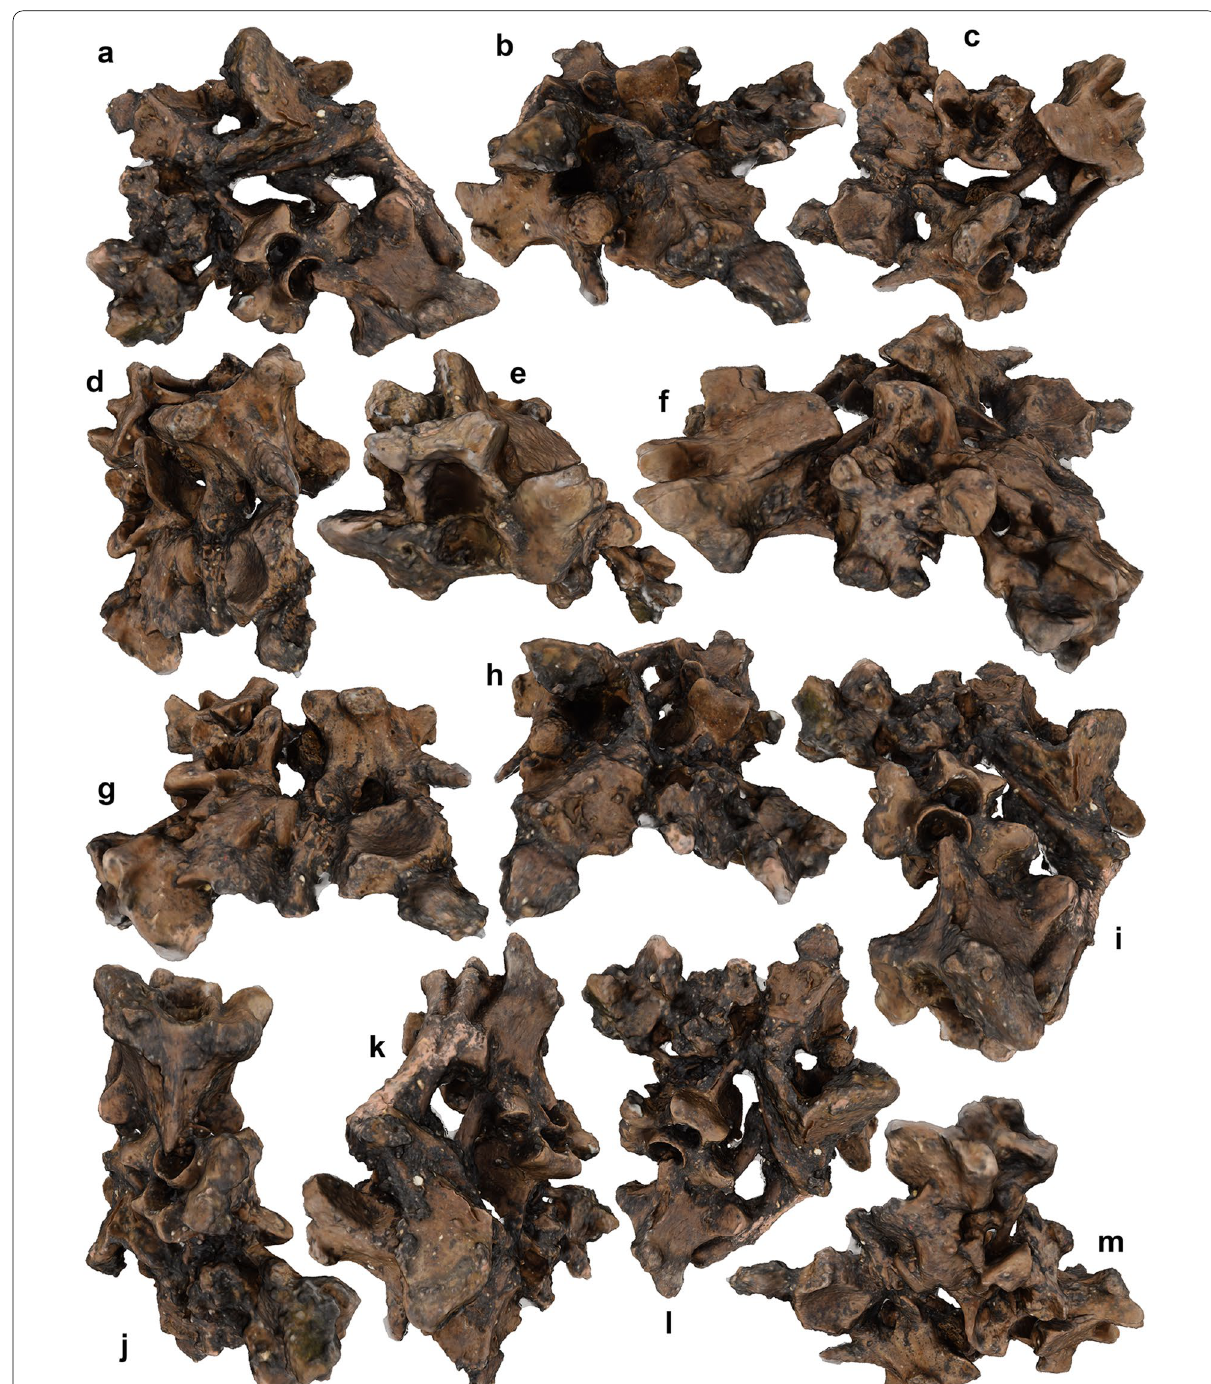
Fig. 69 Eoconstrictor spinifer comb. nov. from quarry Cecilie I, Geiseltal—part of the lectotype (herein designated): 3D models of the “block” including the left atlantal neural arch, three almost complete anterior trunk vertebrae, remains of ribs, fragments of other vertebrae, as well as basioccipital, and right prootic (GMH Ce I-2979-1926) in various views. Images not to the same